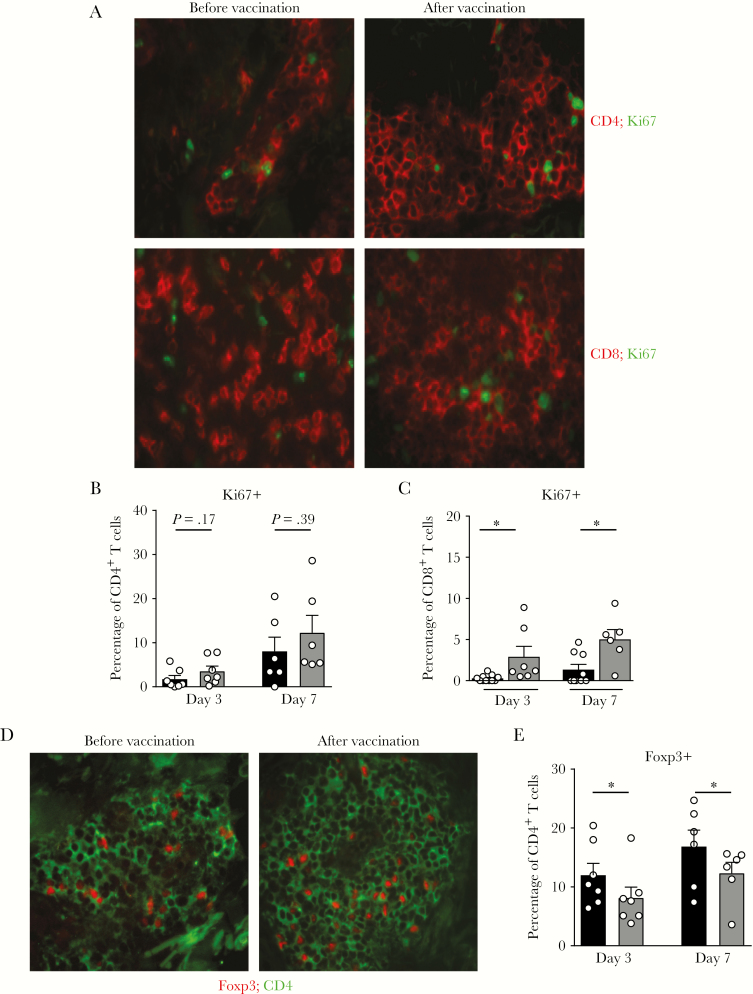
Increased CD8+Ki67+ T cells at the site of varicella zoster virus (VZV) antigen challenge. Punch biopsy specimens (diameter, 5 mm) were performed on days 3 and 7 after VZV antigen challenge, before and after vaccination. A, Representative images showing the frequency of CD4+ (top; red) and CD8+ (bottom; red) T cells expressing Ki67 (green) before and after vaccination. Cumulative data showing the frequency of proliferating CD4+ (B) and CD8+ (C) T cells, before (black) and after (gray) vaccination. D and E, Representative images of CD4 (green) and Foxp3 (red; D) and cumulative data showing the frequency of CD4+ T cells that were Foxp3+ before (black) and after (gray; E) vaccination. Data represent a mixture of paired and unpaired samples and were assessed by the Mann-Whitney test. *P < .05.